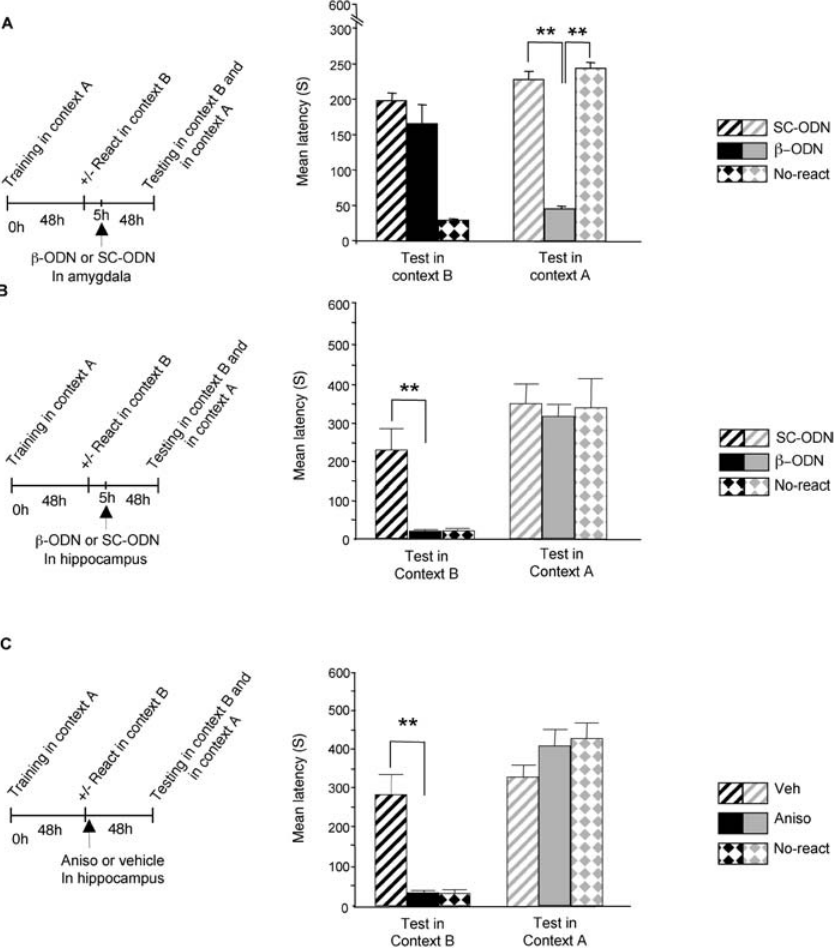
Figure 4. Consolidation, but Not Reconsolidation, Mechanisms Are Required to Associate New Information with a Reactivated Memory Latency to enter the shock chamber was taken as a measure of memory retention. (A) Amygdala injection of b -ODN after memory reactivation disrupted the reactivated memory without affecting the formation of an association between new information and the reactivated memory. b -ODN injection 5 h after reactivation into the amygdala of rats that underwent training in context A and memory reactivation in context B ( n ¼ 7) had no effect on the memory for context B tested 48 h after reactivation. Memory for context B was similar to that of the control group ( n ¼ 8) that received SC-ODN injection. In contrast, the same treatment strongly impaired memory of context A, compared to SC-ODN injection (** ¼ p , 0.01). Memory of context A was not affected in rats that did not receive reactivation ( n ¼ 7). (B) Hippocampal injection of b -ODN blocked the formation of the association between new and reactivated information without affecting the stability of the reactivated memory. b -ODN injection 5 h after reactivation into the hippocampi of rats that underwent training in context A and memory reactivation in context B ( n ¼ 8) significantly impaired the retention for context B 48 h after reactivation, compared with SC-ODN injection (** ¼ p , 0.01). b -ODN injection did not affect the memory of context A, which was similar to that of both control groups that received either SC-ODN injection after reactivation or b -ODN injection in the absence of reactivation ( n ¼ 9 for SC-ODN and n ¼ 6 for b -ODN-injected, No-react). (C) Hippocampal injection of anisomycin blocked the formation of an association between new and reactivated information without affecting the reactivated memory. Anisomycin administration ( n ¼ 8) immediately after memory reactivation in context B significantly impaired memory of context B when tested 48 h later, compared with vehicle injection ( n ¼ 8; ** ¼ p , 0.01). Anisomycin injection did not affect memory of context A ( n ¼ 8; ** ¼ p , 0.01), which was similar to that of vehicle-injected control group ( n ¼ 8 per group). Anisomycin did not affect memory of context A in rats that did not receive reactivation ( n ¼ 8,